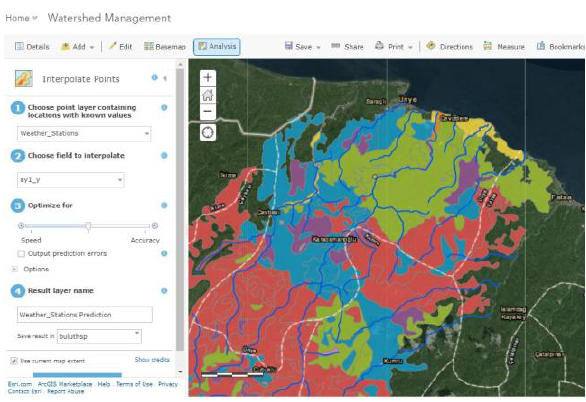
Figure 5: Applying GIS analysis for watershed management purposes on cloud